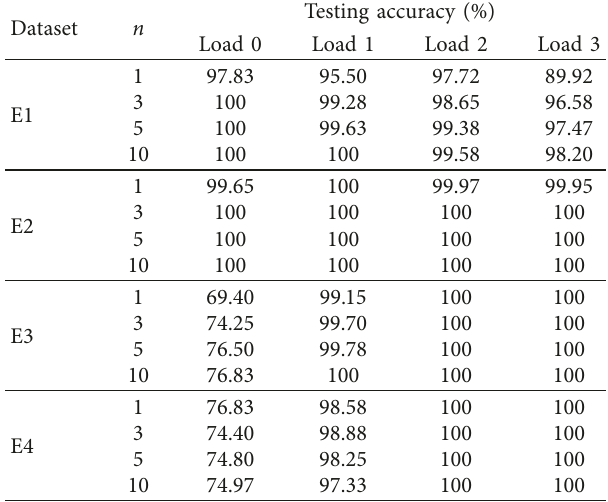
Table 6: The classification accuracy for ball fault severity